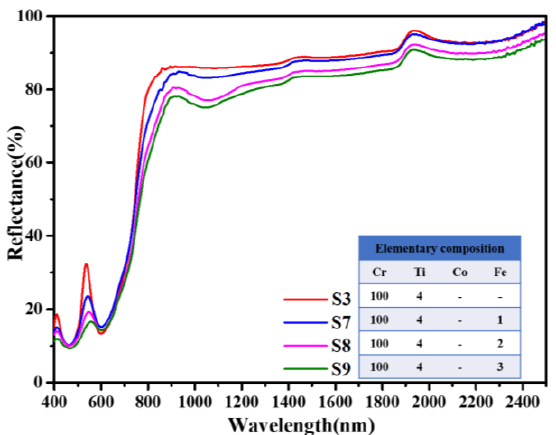
ff use reflectance spectra of Cr 2 O 3